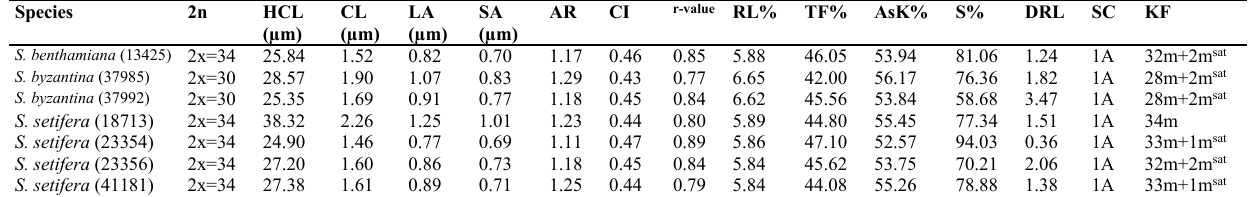
Fig 1. Karyotypes, idiograms and karyograms of A) S. benthamiana (13425); B) S. byzantina (37985); C) S. byzantina (37992); D) S. setifera (18713); E) S. setifera (23354); F) S. setifera (23356); G) S. setifera (41181). Scale bar = 1 µm. Table 2. Chromosome, karyotype, and asymmetry parameters were measured on the seven populations of the studied Stachys species.